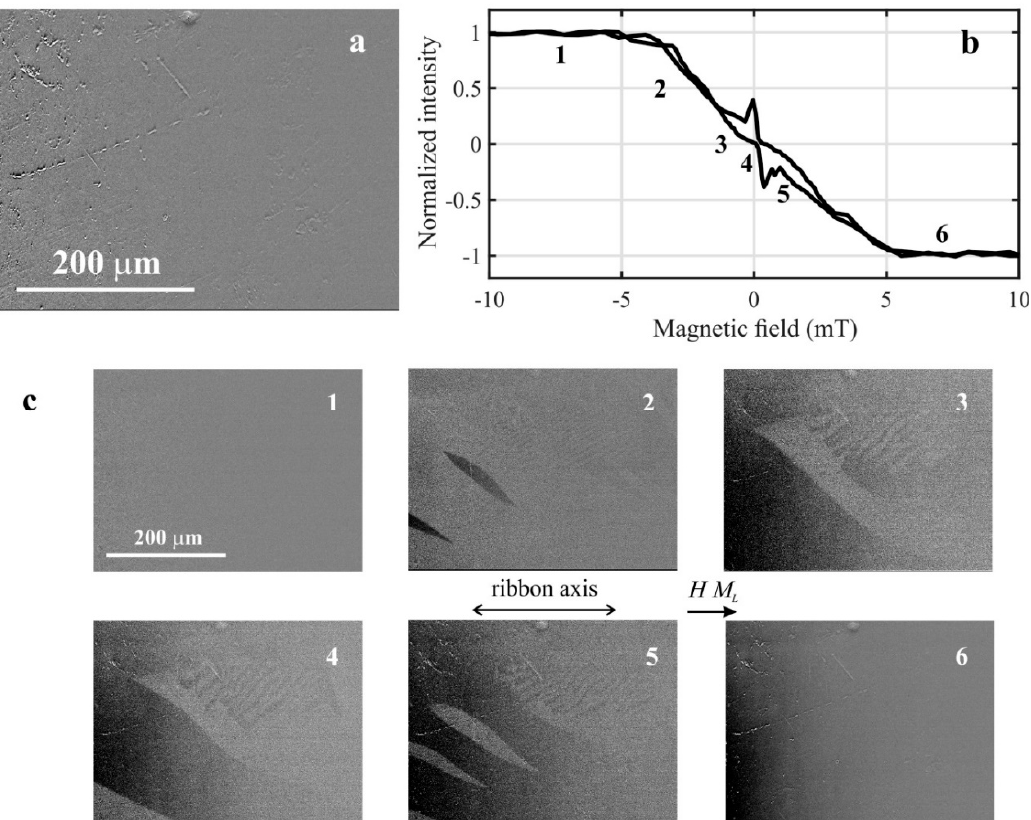
Figure 4. Selected illuminated area on the air-surface of amorphous Fe 80 Si 4 B 16 ribbon ( a ), normalized magneto-optical hysteresis loop ( b ), and consecutive magnetic domain patterns (1 to 6) obtained during switching magnetic field from negative to positive saturation ( c ).